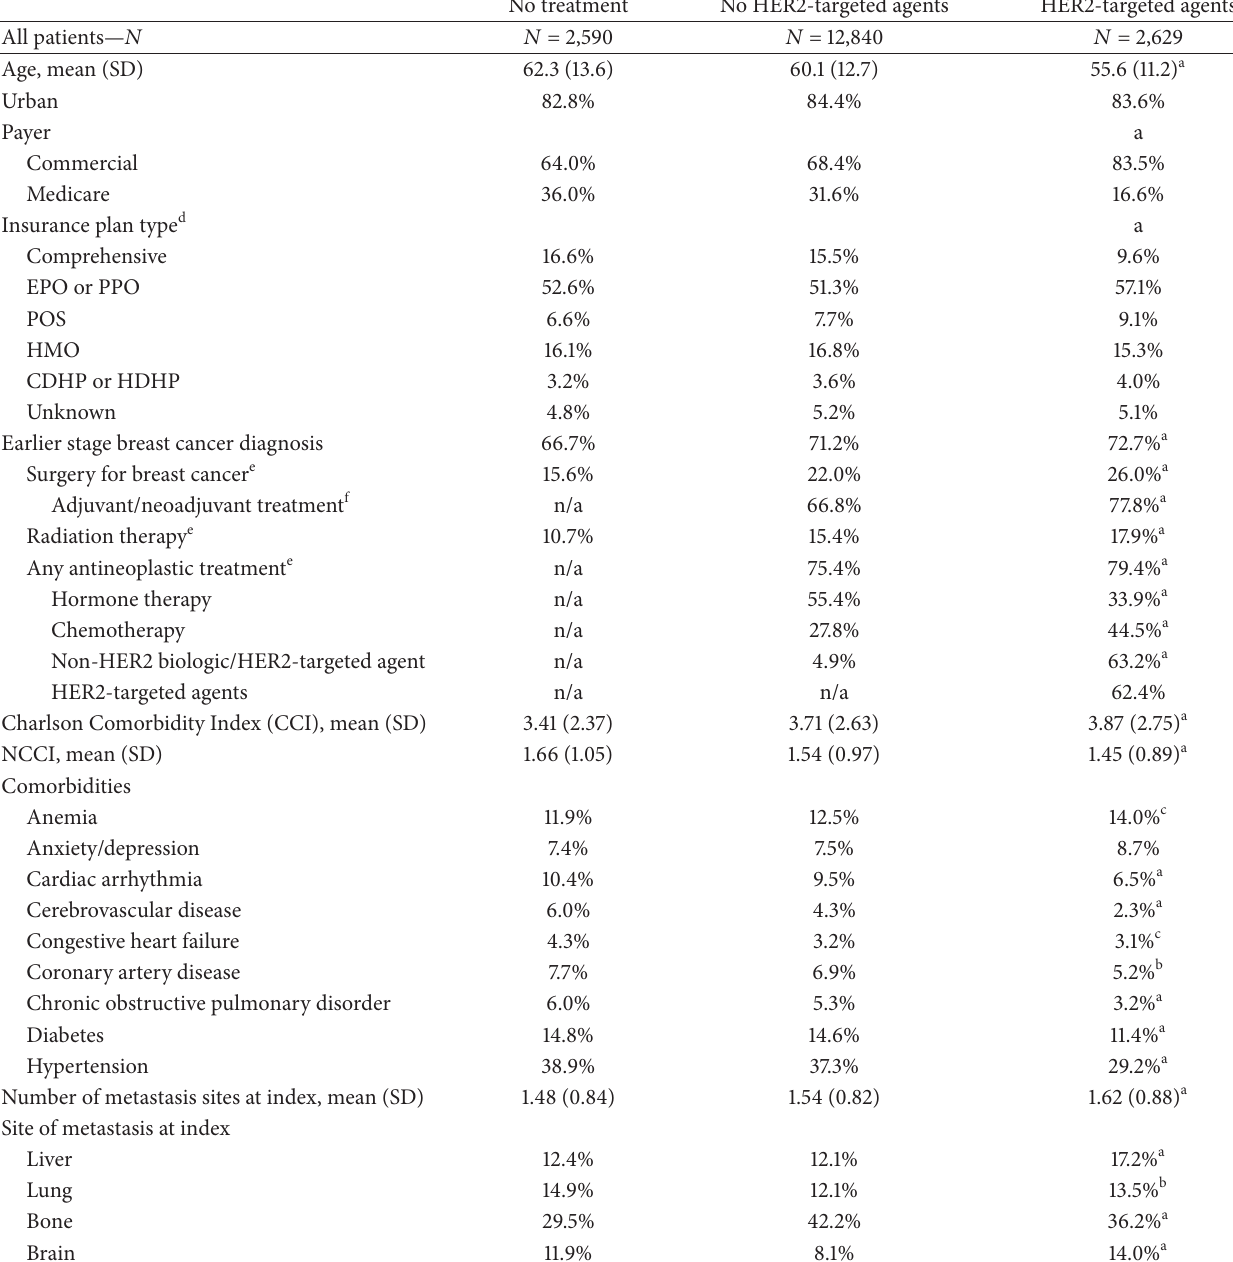
Table 1: Demographic characteristics and clinical history by receipt of HER2-targeted